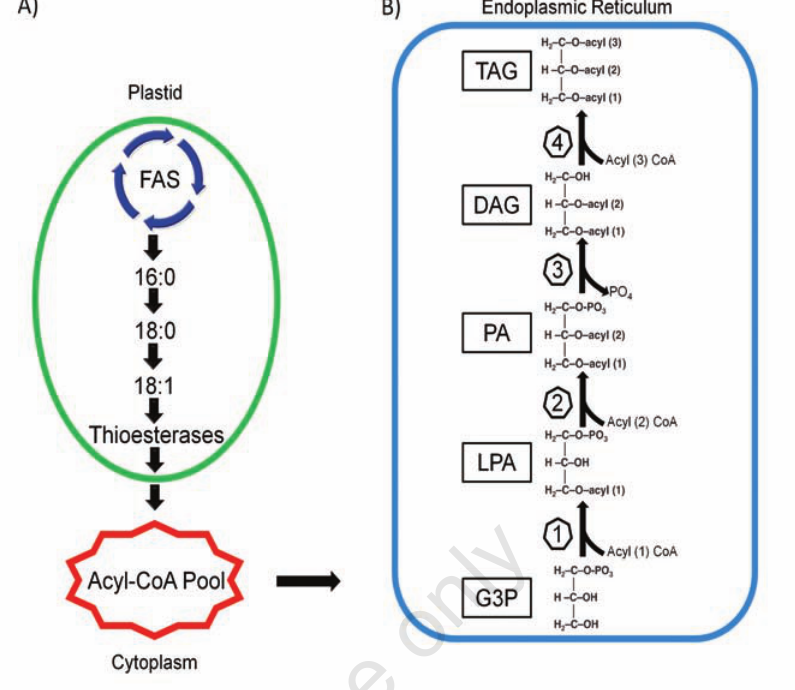
Figure 1. Fatty acid biosynthesis and Kennedy pathway for triacylglycerol biosynthesis in plants. (A) Fatty acid synthesis occurs in plastids through repeated steps of condensa- tion by the action of several enzymes that compound the fatty acid synthase complex (FAS), which promotes the consecutive addition of two carbon units for each elongation cycle to form 16:0. Then, the elongation of 16:0 occurs to form 18:0 and the first desat- uration step where 18:0 originates 18:1. The termination of fatty acid elongation is cat- alyzed by thioesterases enzymes and these three fatty acids are then exported to the cytosol into the acyl-CoA pools and are able to be accumulated as TAG molecules. (B) Kennedy pathway starts with acylation of glycerol-3-phosphate (G3P) to form lysophos- phatidic acid (LPA) through the action of sn -glycerol-3-phosphate acyltransferase (1). The second acyl-CoA dependent acylation is catalyzed through the catalytic action of lysophosphatidic acid acyltransferase (2), leading to the formation of phosphatidic acid (PA). Phosphatidic acid phosphatase (3) catalyzes the release of phosphate from PA to produce DAG. The final acylation is driven by diacylglycerol acyltransferase (4) that con- verts DAG into